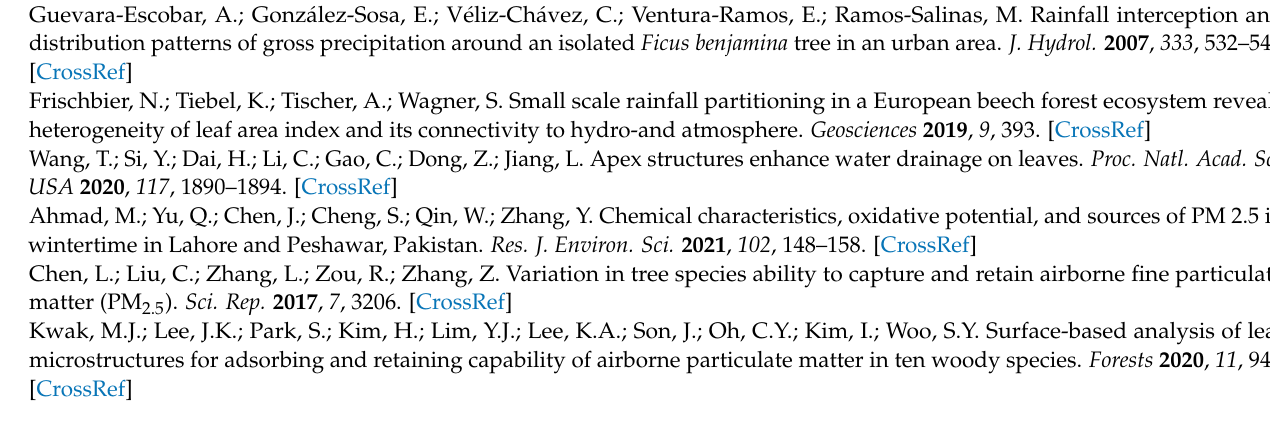
surfaces; Figure S3: Correlation matrix for all pairs of the observed variables between leaf macro-scale and net PM wash-off ability from the outer crown-positioned leaves; Figure S4: Correlation matrix for all pairs of the observed variables between leaf micro-scale and net PM wash-off ability from the outer crown-positioned leaves; Figure S5: Correlation matrix for all pairs of the observed variables between leaf geometric properties and net PM wash-off ability from the outer crown-positioned leaves; Figure S6: Correlation matrix for all pairs of the observed variables between leaf macro-scale and net PM wash-off ability from the inner crown-positioned leaves; Figure S7: Correlation matrix for all pairs of the observed variables between leaf micro-scale and net PM wash-off ability from the inner crown-positioned leaves; Figure S8: Correlation matrix for all pairs of the observed variables between leaf geometric properties and net PM wash-off ability from the inner crown-positioned leaves; Table S1: Quantitative assessment of retained PM and wash-off on leaf surfaces and wax layers during rainfall events; Table S2: Leaf macro-scale properties of individual leaf shape descriptors in urban forest tree species; Table S3: Leaf micro-scale structural properties of individual leaf surfaces in urban forest tree species; Table S4: Leaf geometric properties in urban forest tree